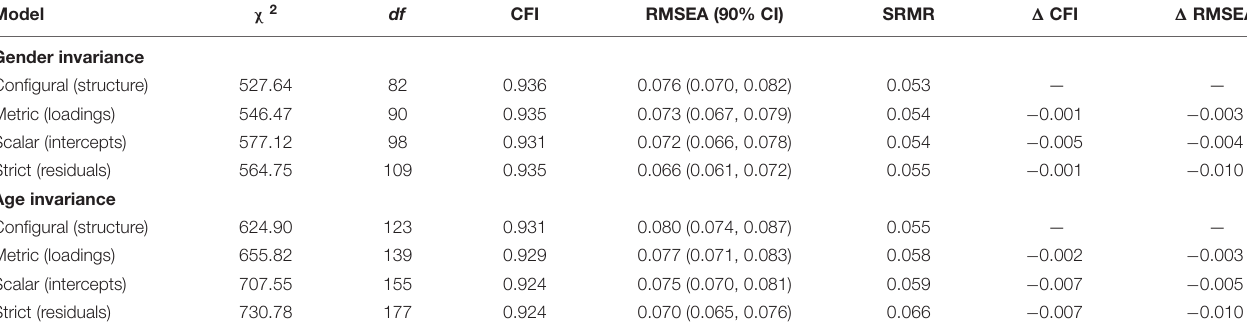
TABLE 1 | Fit indices for measurement invariance of the Japanese HEMA scale (11 items). Model